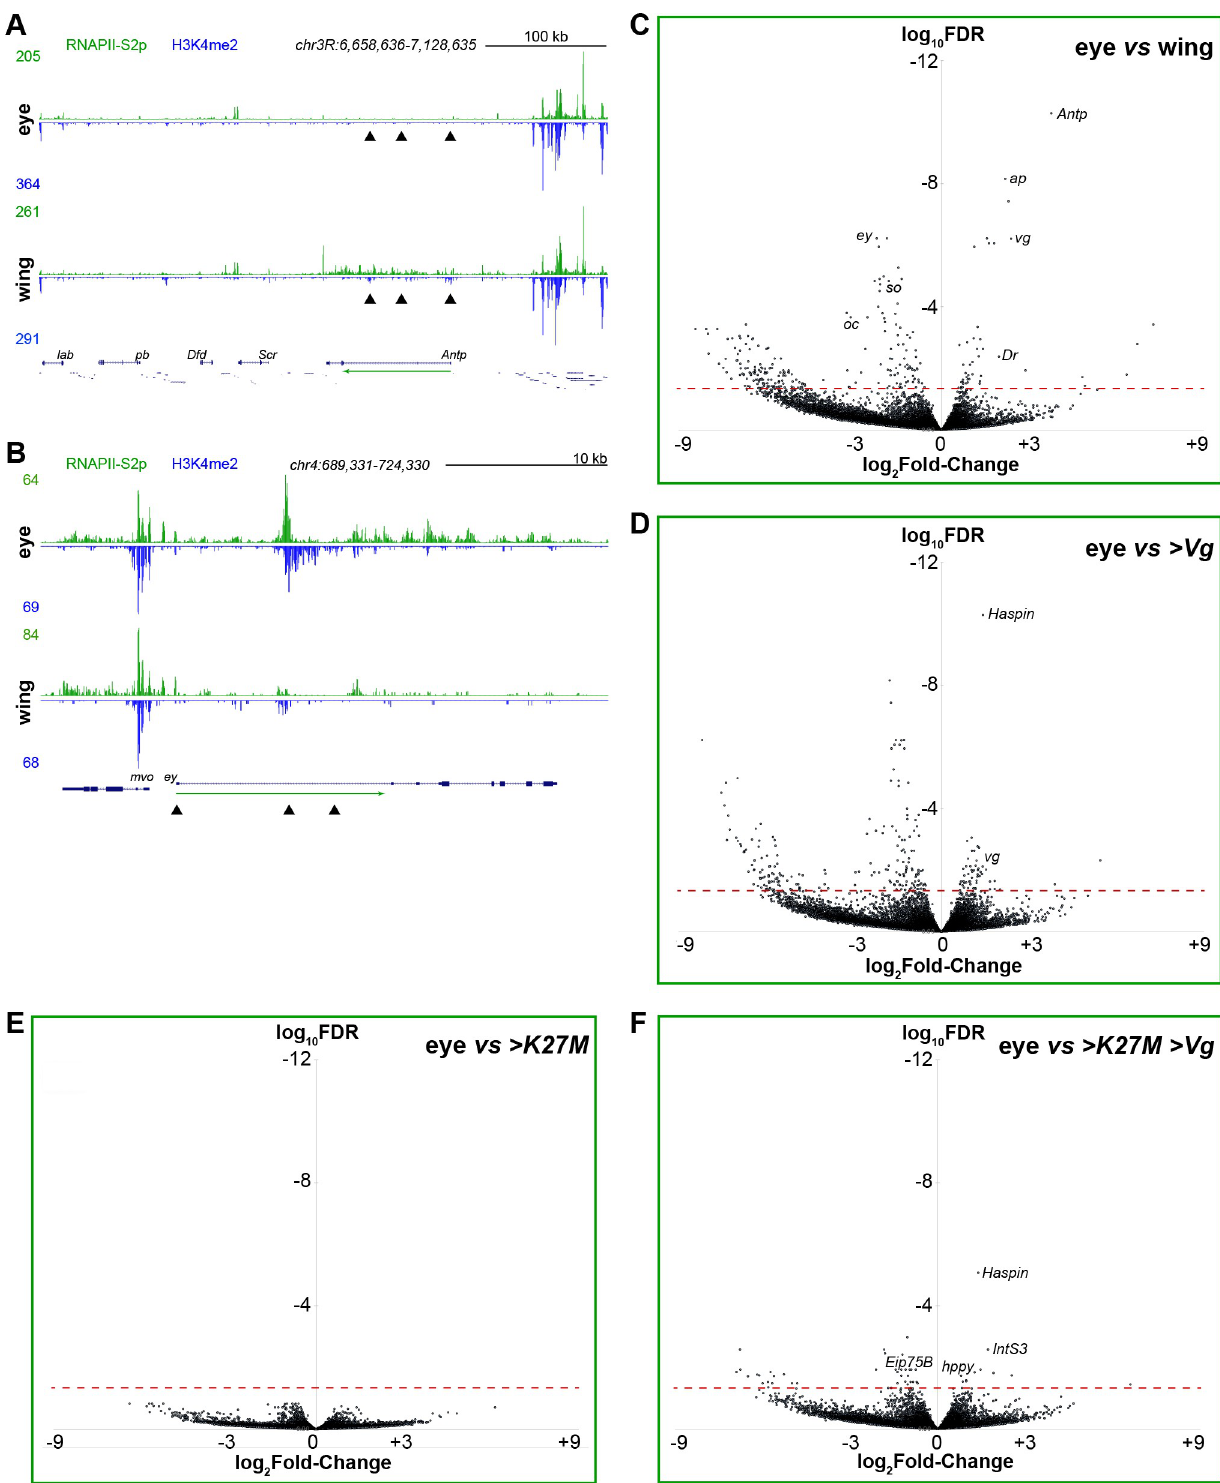
Fig 6. Chromatin profiling of elongating RNAPII and H3K4me2 in reprogrammed eye imaginal discs. ( A,B ) RNAPII-S2p and H3K4me2 signal across the ANTP-C ( A ) and the ey gene ( B ). Arrowheads indicate alternative promoters of the Antp and the ey genes, and the green arrow indicates the direction of transcription. ( C-F ) Volcano plots of differentially-expressed genes between wildtype ( w 1118 ) eye imaginal discs, wing imaginal discs, and eye discs with H3.3K27M and Vg production. Selected genes that are significantly differentially-expressed are marked.